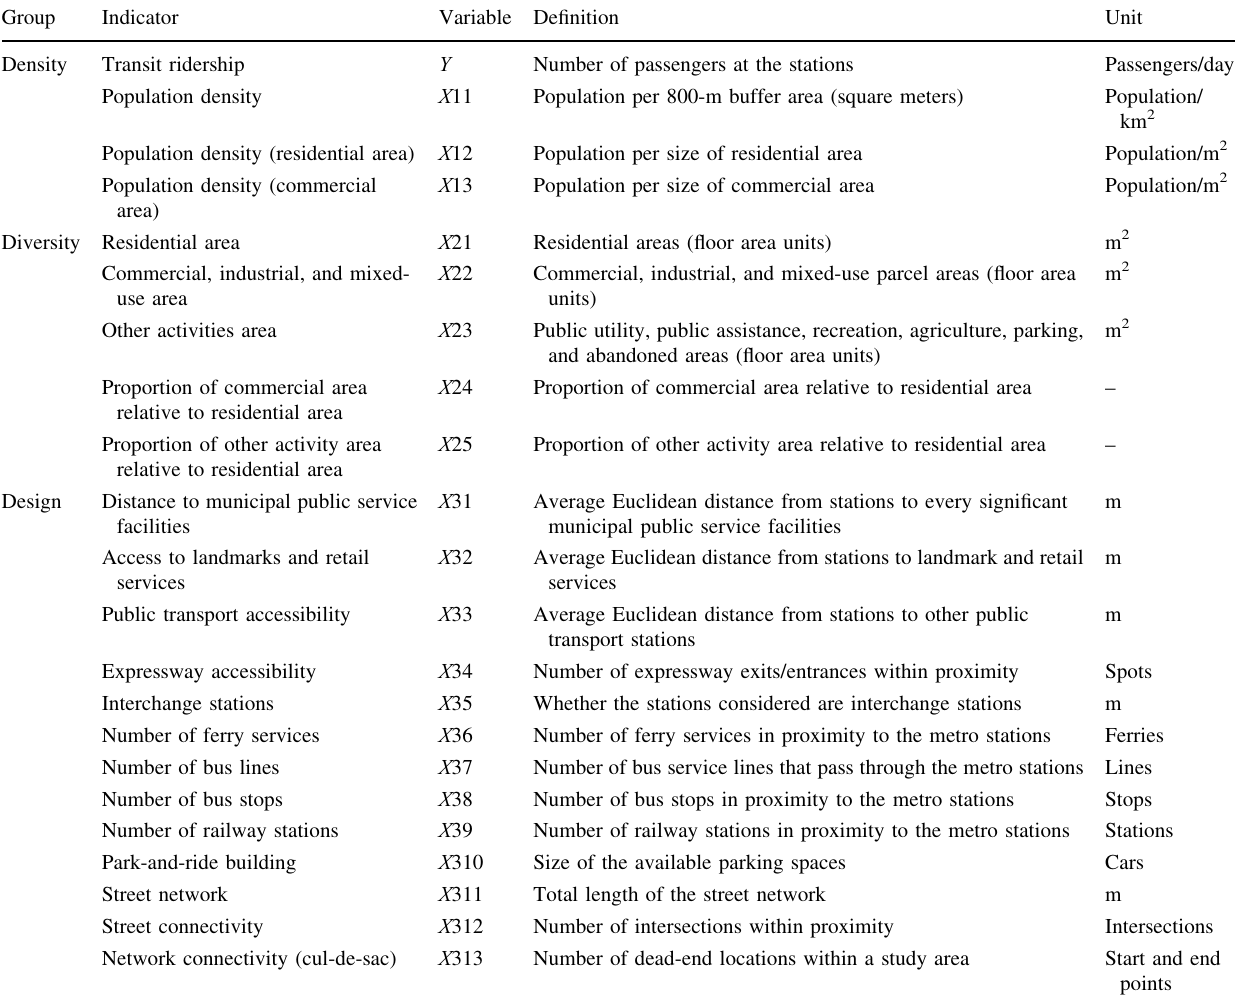
Table 3 List of selected variables Group